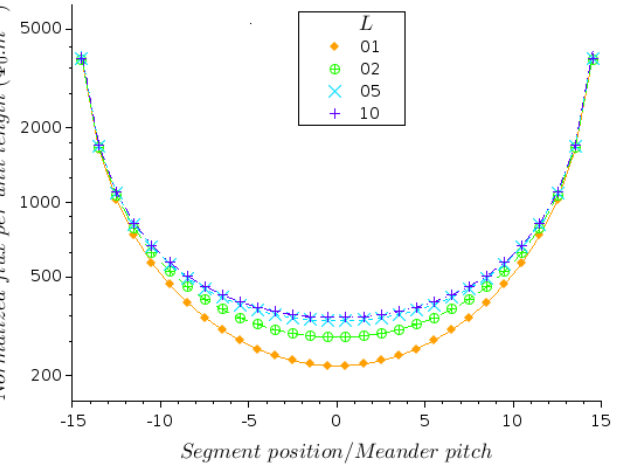
Figure 5. Flux distribution over the SQUIDs located at the center of each segment of the meander geometry for a bias current I = 100 µ A and different segment lengths W y = L . W x . The symbols are located at the position of the center of each segment. The flux per unit length is given in Φ 0 / m